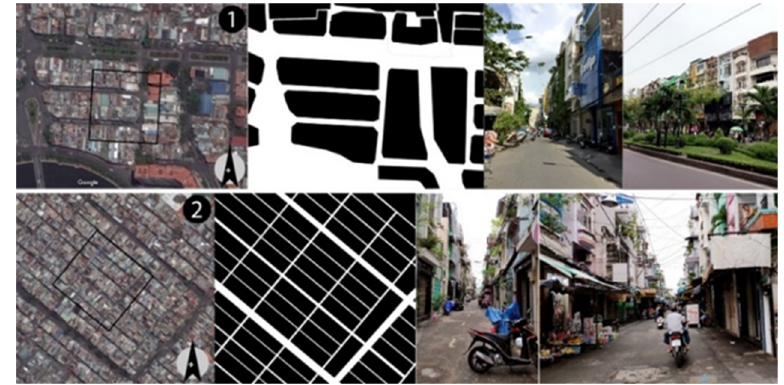
Figure 14. Urban pattern of two samples: Type 2 ( 1 ), Type 3 ( 2 ).